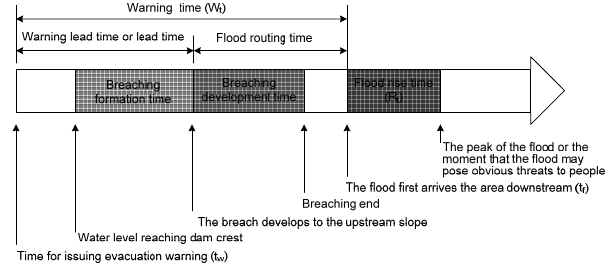
Fig. 2. Schematic of the dam breaching and warning time.